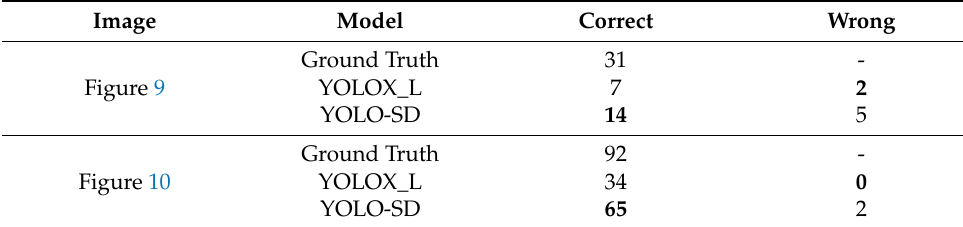
YOLOX_L 34 0 YOLO-SD 65 2 Correct indicates the number of ship targets successfully detected, Wrong means the number of false detections, and bold data is the best result.